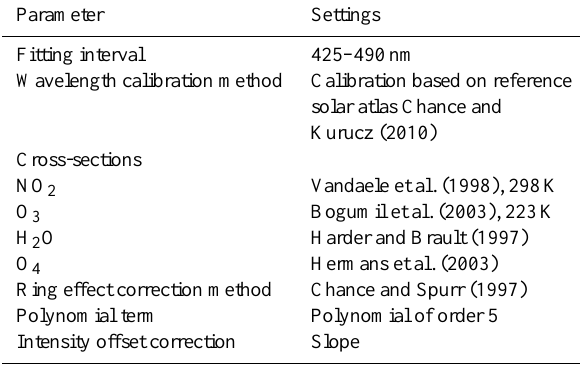
Table 1. Main DOAS analysis parameter settings for NO 2 slant col- umn spectral fit, in accordance with the NDACC UV-Vis Working Group recommendations (Van Roozendael and Hendrick,